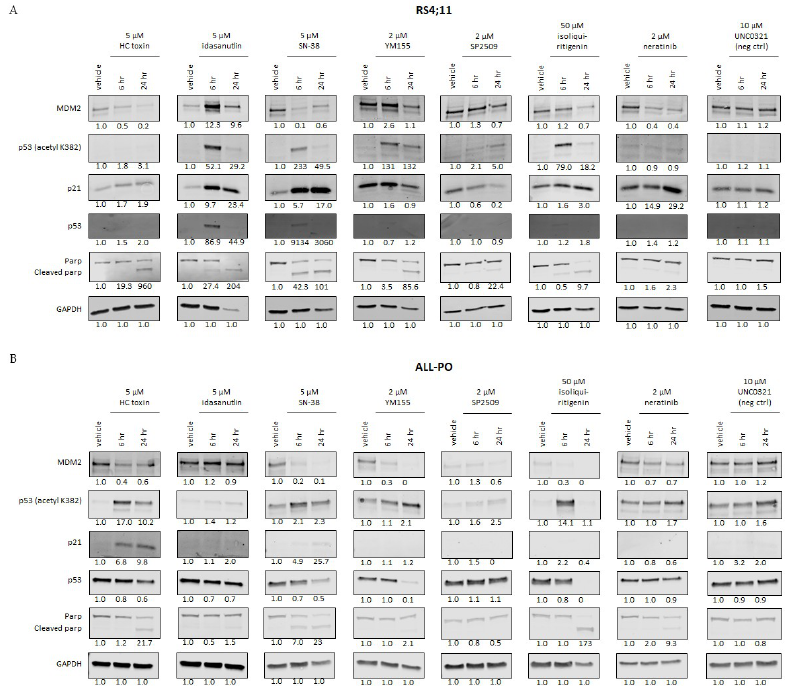
Figure 3. Candidate drugs affect the expression of the p53 pathway in KMT2A–AFF1 ALL cells: western blot analysis showing the protein expression of MDM2, p53 acetylation at lysine 382, p21, p53, and cleaved PARP upon exposure to eight candidate drugs at indicated concentrations or vehicle controls for 6 and 24 h in the cell lines ( A ) RS4;11 and ( B ) ALL-PO. Expression of GAPDH was used as a loading control. Quantification of the expression was relative to GAPDH and normalized to vehicle controls. The ratio cleaved PARP:PARP was used for quantification of PARP cleavage. UNC0321 was used as negative